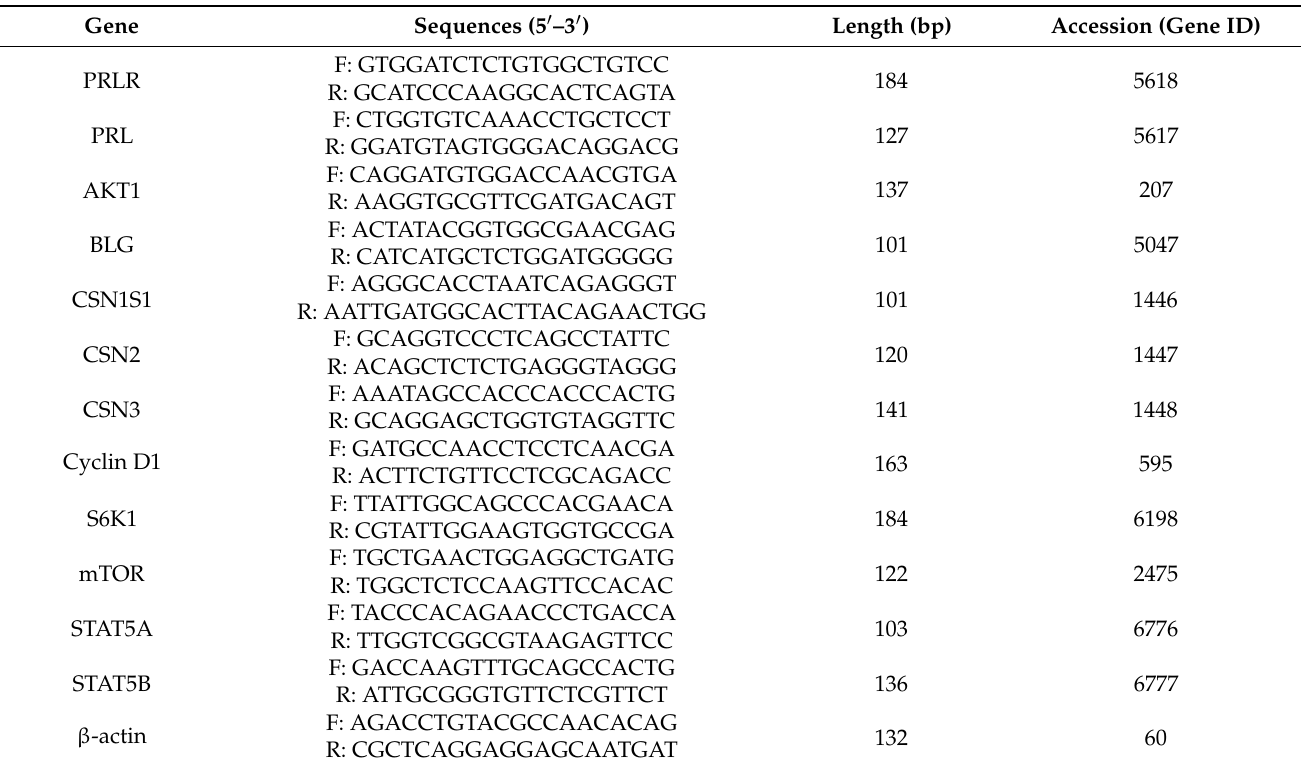
Table 2. Primer sequences for qRT-PCR